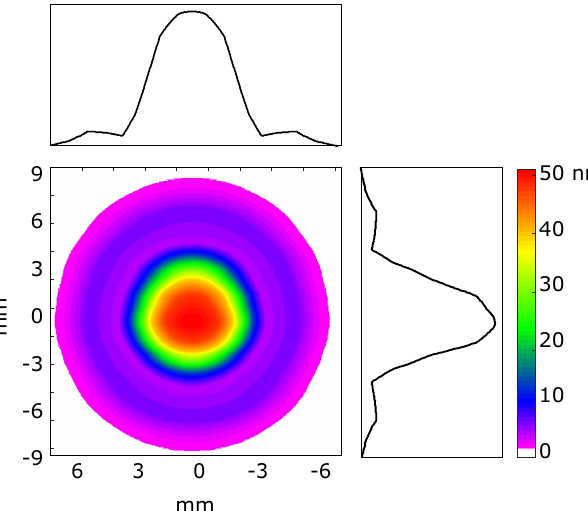
Figure 8. Wavefront simulation of beam phase at the end of beamline FL21. Beam only contained distortions from the two plane beamline-mirror profiles. Perfect Gaussian source was assumed to start